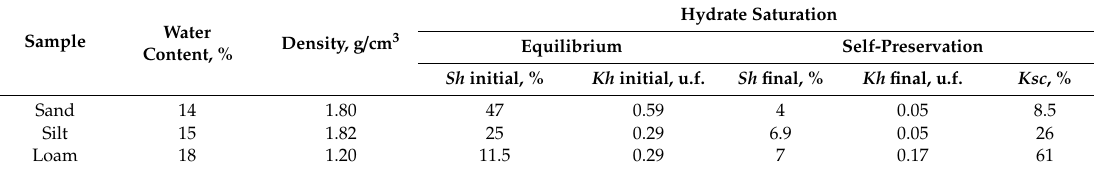
Table 3. Hydrate saturation in frozen hydrate-saturated samples.